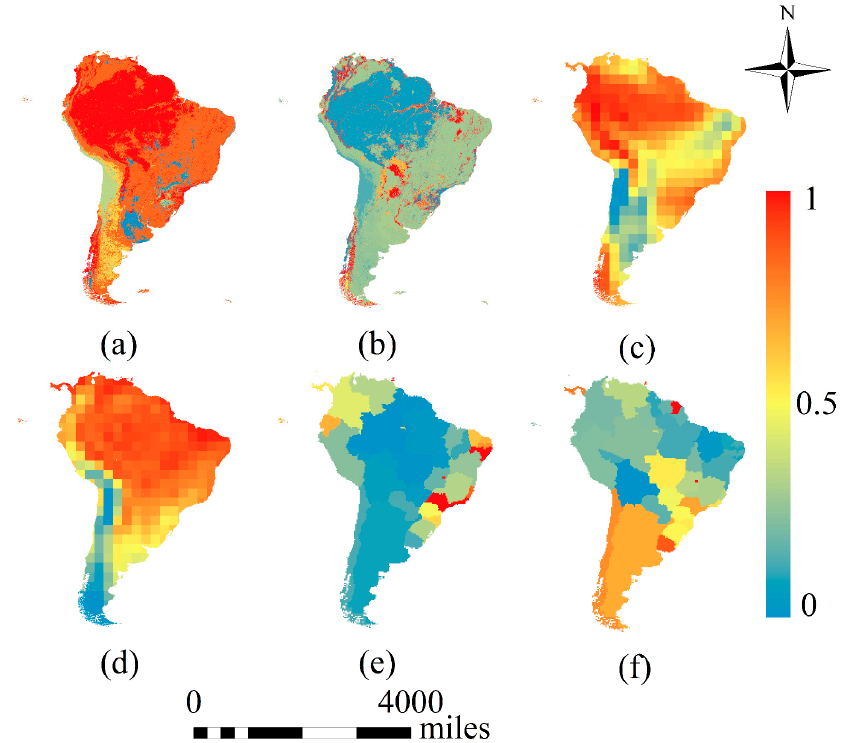
Figure 3. Normalized environmental factors affecting the spread of ZIKV. Population density and GDP per capita are measured by country (by state in Brazil), while other data are measured at the pixel scale. ( a – f ) represent biodiversity, landscape fragmentation, relative humidity, temperature, population density and GDP per capita respectively.